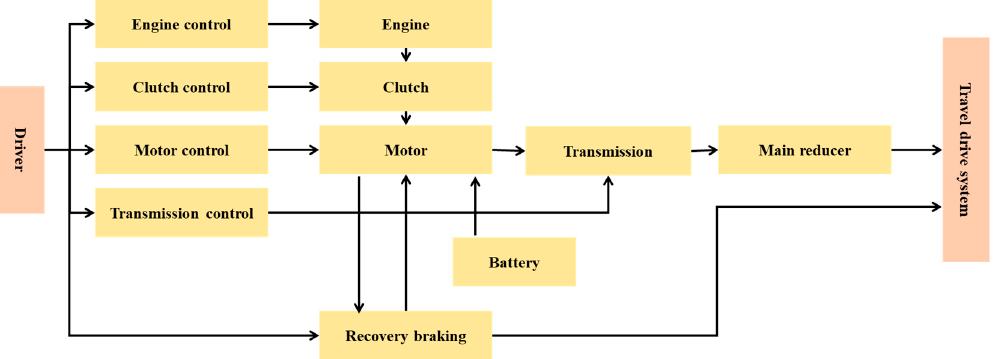
Figure 5. Hybrid electric vehicle power system